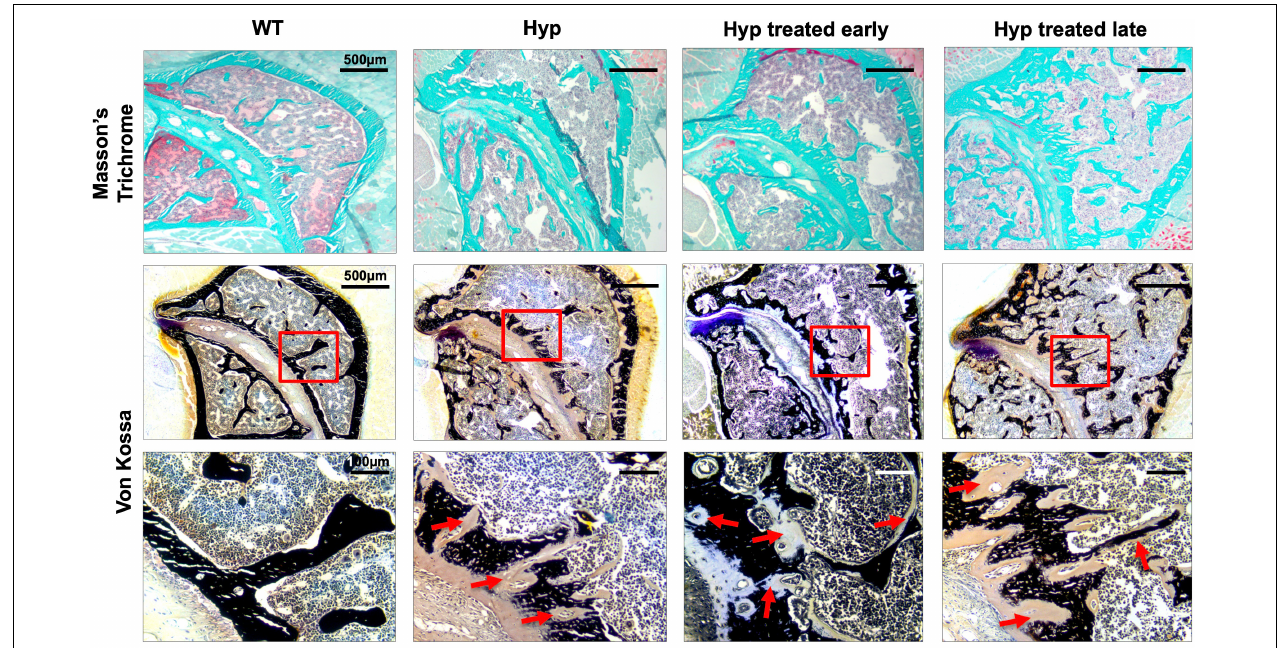
FIGURE 4 | Masson’s Trichrome and Von Kossa staining of sacroiliac joint of 3-month-old WT mice, untreated Hyp mice, and Hyp mice on conventional treatment started early or late. Masson’s Trichrome and Von Kossa staining showed a weaker mineralization (in dark) of the collagen matrix revealing an enlarged osteoid (red arrows) characteristic of features of osteomalacia bone in Hyp mice compared to WT. Despite the conventional treatment, Hyp mice treated early or late show an accumulation of osteoid (red arrows).